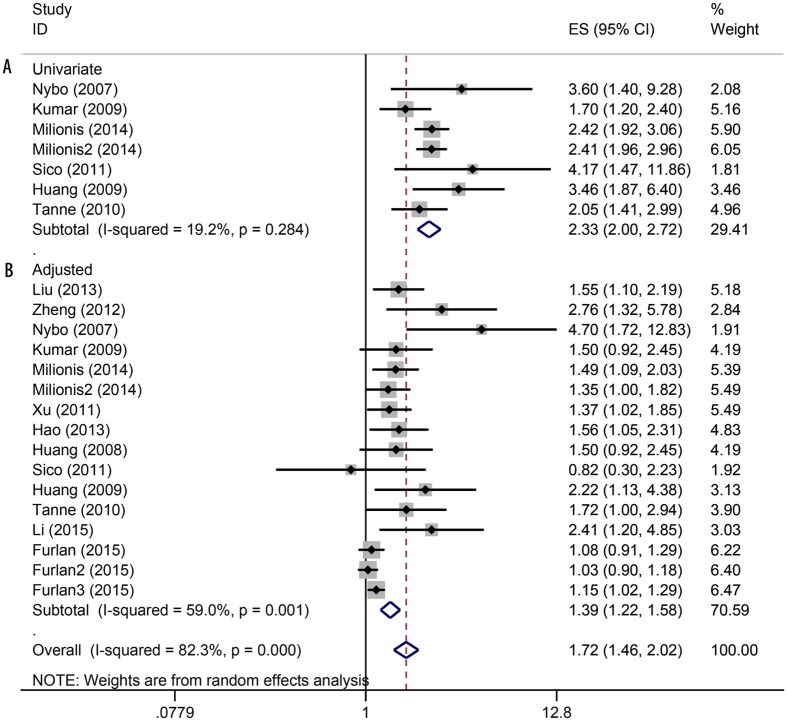
Forest plot showing the mortality risk of anemia in patients with stroke.